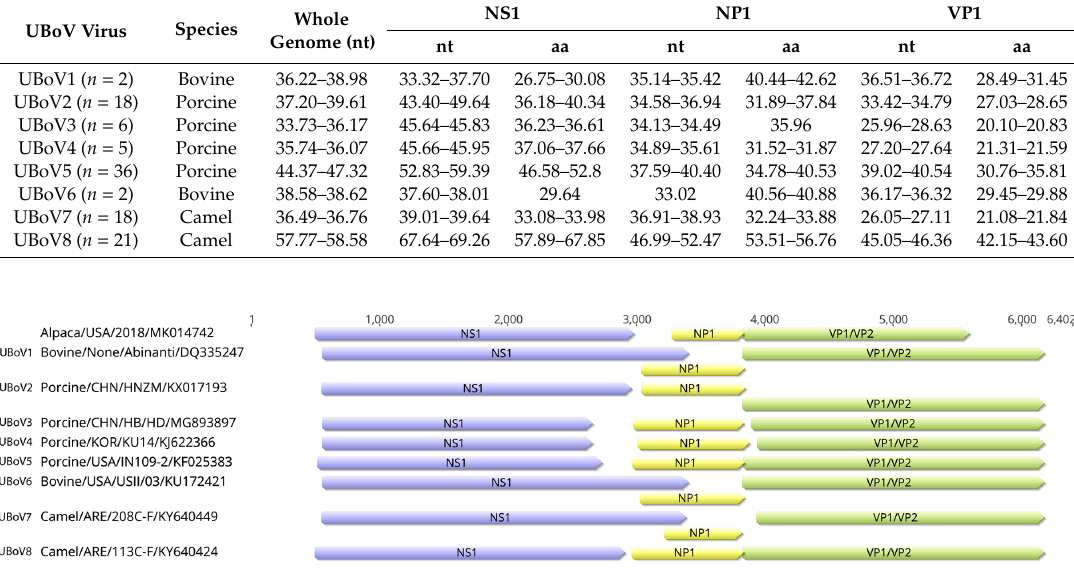
Figure 2. Genome organization of AlBoV compared to UBoV1–8. The purple, yellow, and green boxes indicate the NS1, NP1, and VP1/VP2 open reading frames (ORFs), respectively.